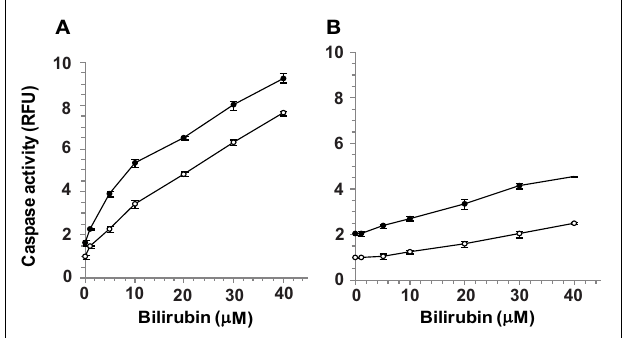
FIGURE 2 |Apoptotic effects of UCB and glucose in microvascular endothelial cells. Confluent cultures of bEnd3 (A) or MS1 (B) cells were ◦ incubated for 48h with culture medium containing normal (5.5mM; - -) or • high (25mM; - -) glucose, in the absence or presence of increasing concentrations of UCB added during the last 24h of incubation. Caspase activity was determined using the carboxyfluorescein-FLICA probe (see Materials and Methods) and was expressed as relative fluorescence units (RFU), calculated by dividing the individual fluorescence values for the different treatments by that obtained for cells exposed to 5.5mM glucose in the absence of UCB (the latter were assigned a value of 1). Experiments were repeated at least three times.The results of a representative experiment are shown as Mean ± Standard Deviation.Values for the bEnd cells at all UCB concentrations differ from the values obtained in the absence of UCB (statistically significant at p < 0.05).Values for the MS1